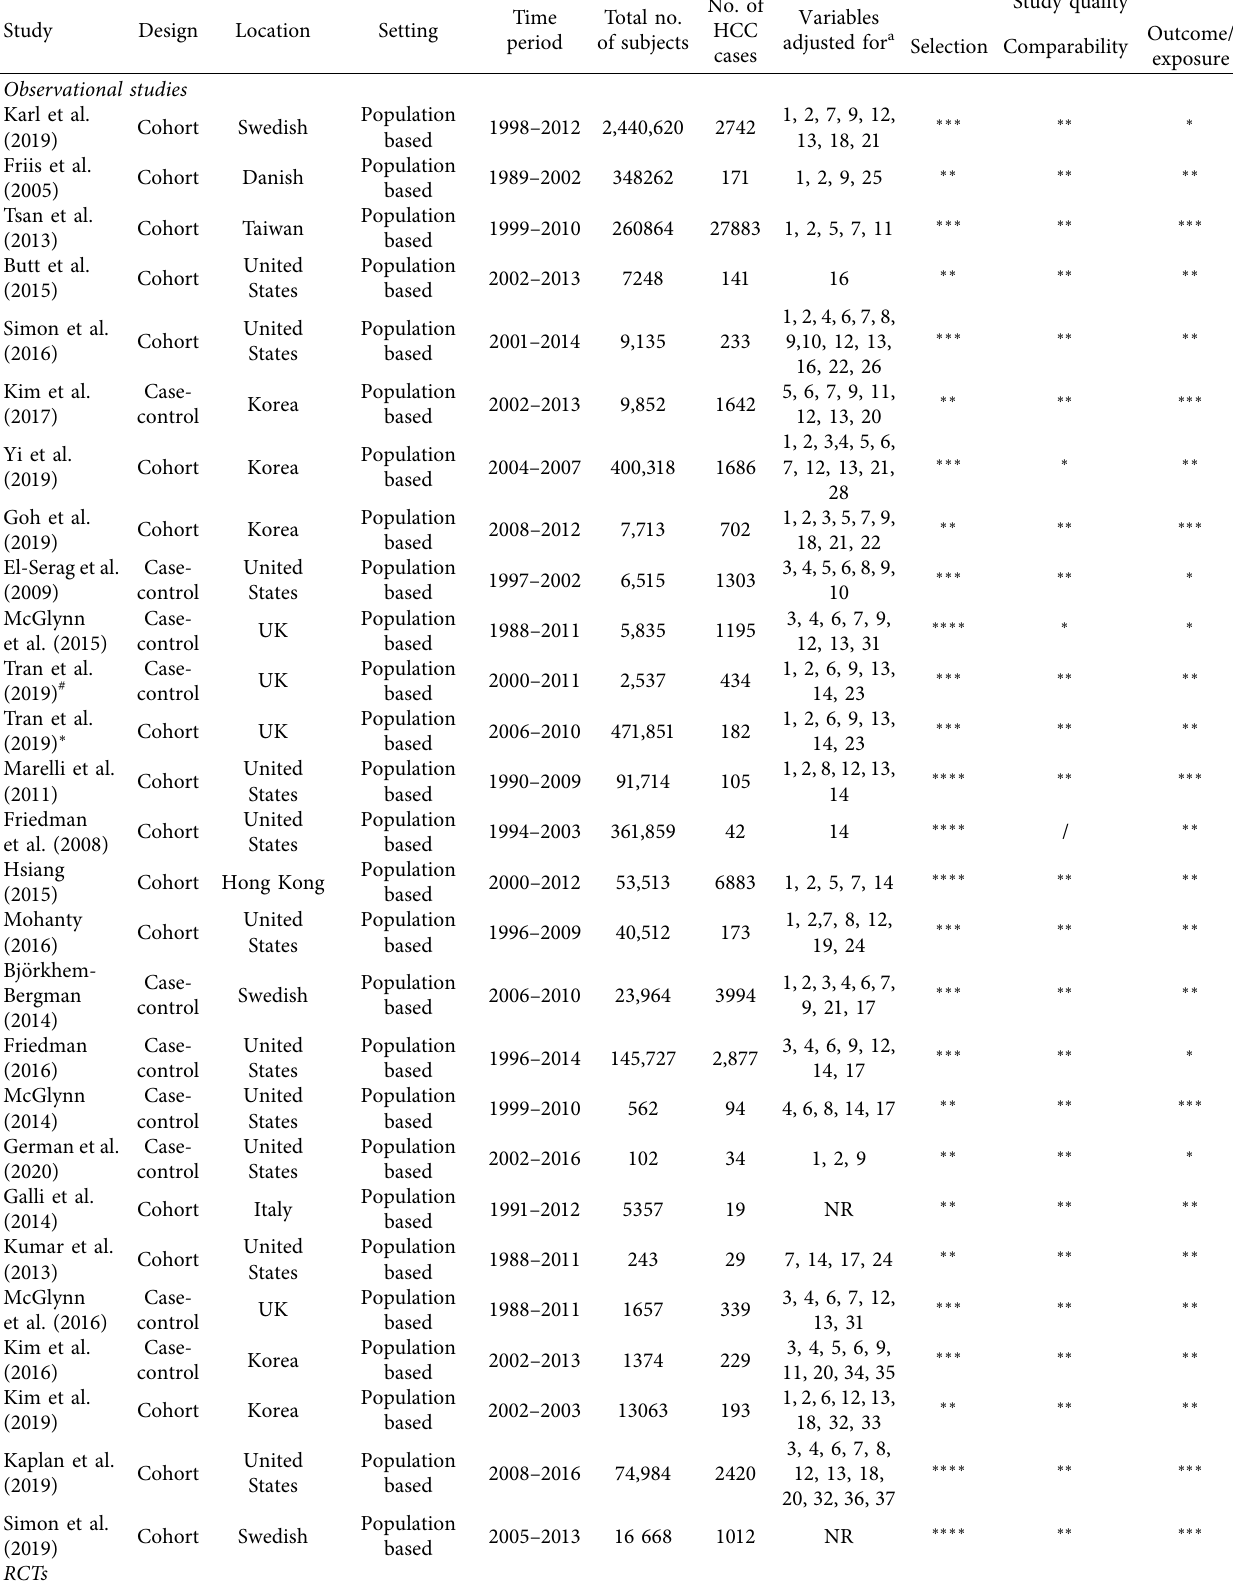
Table 1: Characteristics and quality of included studies assessing the risk of HCC with statin